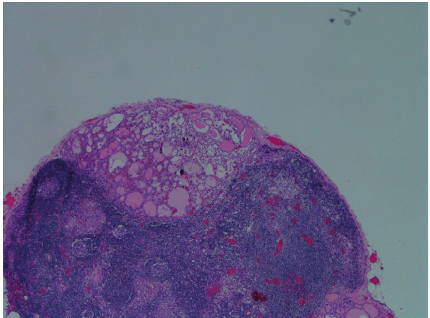
Figure 4: Positive lymph node: the image shows lymph node partially replaced by tumor